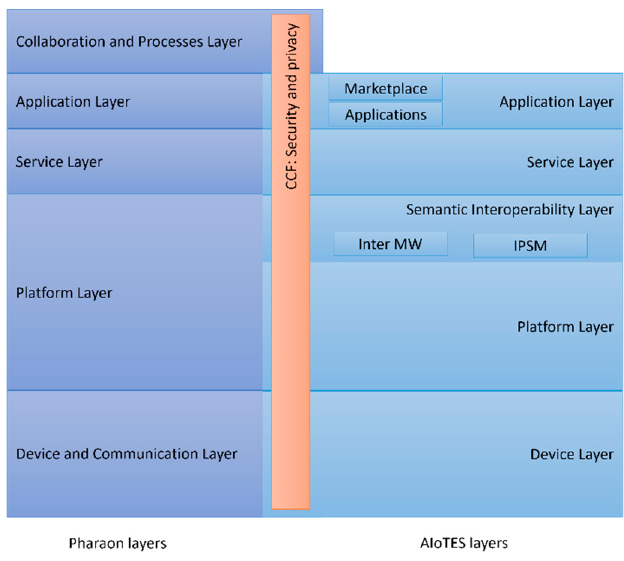
Figure 6. Pharaon–AIoTES layers mapping.